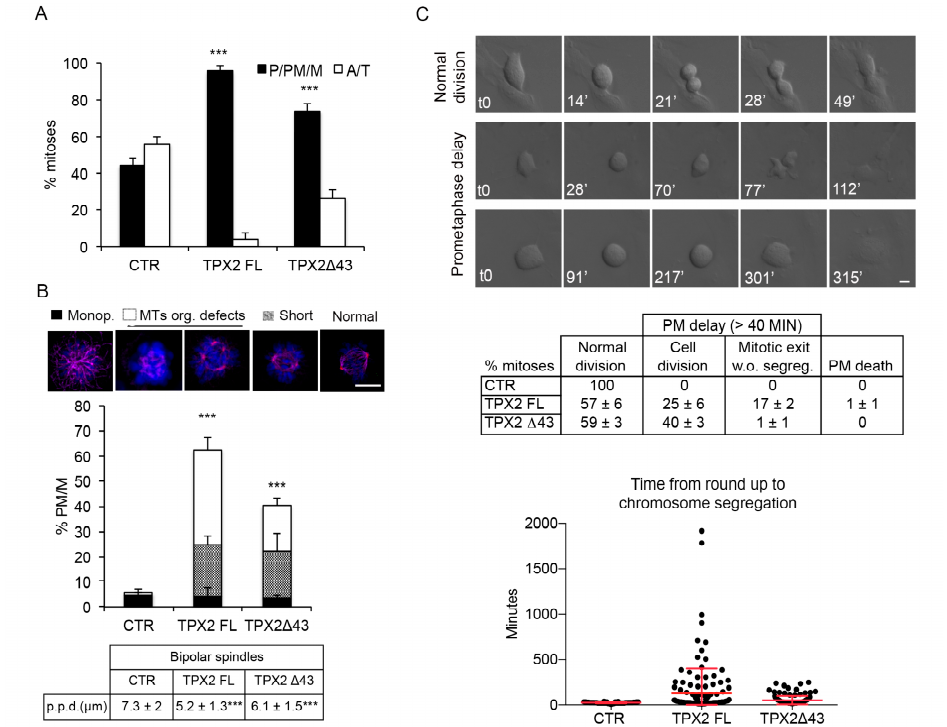
Figure 3. TPX2 overexpression delays progression through prometa / metaphase in non-transformed cells and yields cell division failure. ( A ) Histograms display the distribution in the indicated cell lines of mitotic cells in pro / prometa / metaphase (P / PM / M) or ana / telophase (A / T) after induction (24 h). A total of 300 mitotic cells were counted per condition, from three independent experiments; s.d. are shown. ( B ) TPX2 overexpression (24 h induction, methanol-fixed) leads to aberrant mitotic spindle organisation; quantification of scored defects (monopolar spindle, MT organisation defects, short spindles) exemplified in the IF panels (4,6-diamidino-2-phenylindole (DAPI) in blue; α -tubulin in purple), is shown in the histograms below. At least 250 prometa/metaphases (PM/M) were counted per condition, from three independent experiments; s.d. are shown. *** p < 0.0001, chi-square (and Fisher’s exact) test. The table below indicates the pole-to-pole distance (p.p.d.) measured in bipolar spindles only, in late prometaphases/metaphases under the indicated conditions. At least 90 spindles were measured per condition, from three independent experiments. *** p < 0.0001; one-way ANOVA, Tukey’s multiple comparisons test. ( C ) Time lapse video recording of VENUS (CTR) and TPX2 (FL or Δ 43)-overexpressing cells, from the time of induction for the following 48 h. Differential interference contrast (DIC) still frames show a normal mitosis (top), and two examples of delayed prometaphase, either followed by cell division (middle) or by re-adhesion without chromosome segregation (lower panels). Minutes from round-up (t0) are indicated. Phenotypes (%) are shown in the table, while the dot plot indicates the time required (minutes) from round-up to the first signs of chromosome segregation (single measures, as well as the average values and s.d., are shown). Each dot represents a single mitosis; at least 100 cells were analysed per condition, from three independent experiments. Cells spending “ > average control time + 2 s.d.” ( > 40 min) in a prometa / metaphase state were considered as delayed. Scale bars: 10 µ